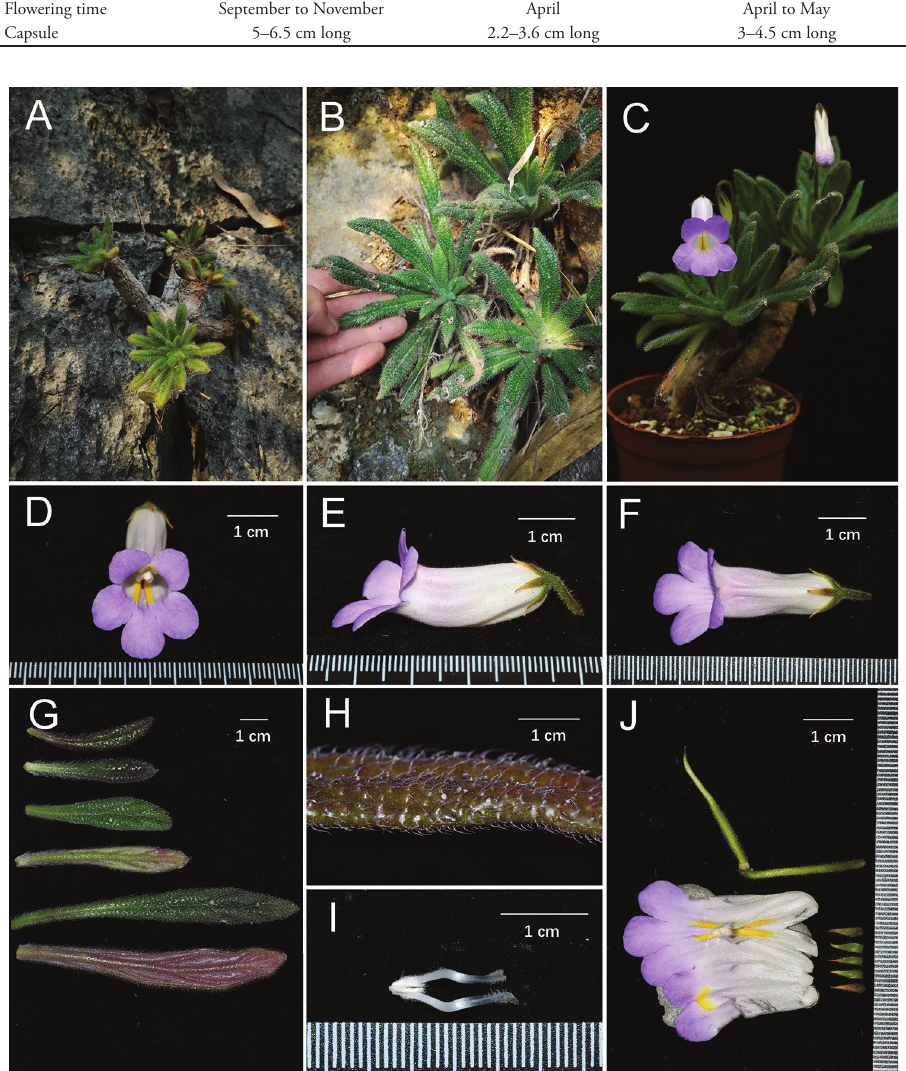
Figure 1. Primulina papillosa A, B habitat C habit D front view of the corolla E lateral view of the co- rolla F top view of the corolla G adaxial and abaxial surface of leaf blades H papillose-hispid hairs on leaf blade surface I stamens J pistil, calyx and opened corolla with stamens and staminodes. ( A, B photos by W.C. Chou, C–J photos by F. Wen; arranged by Z.B.